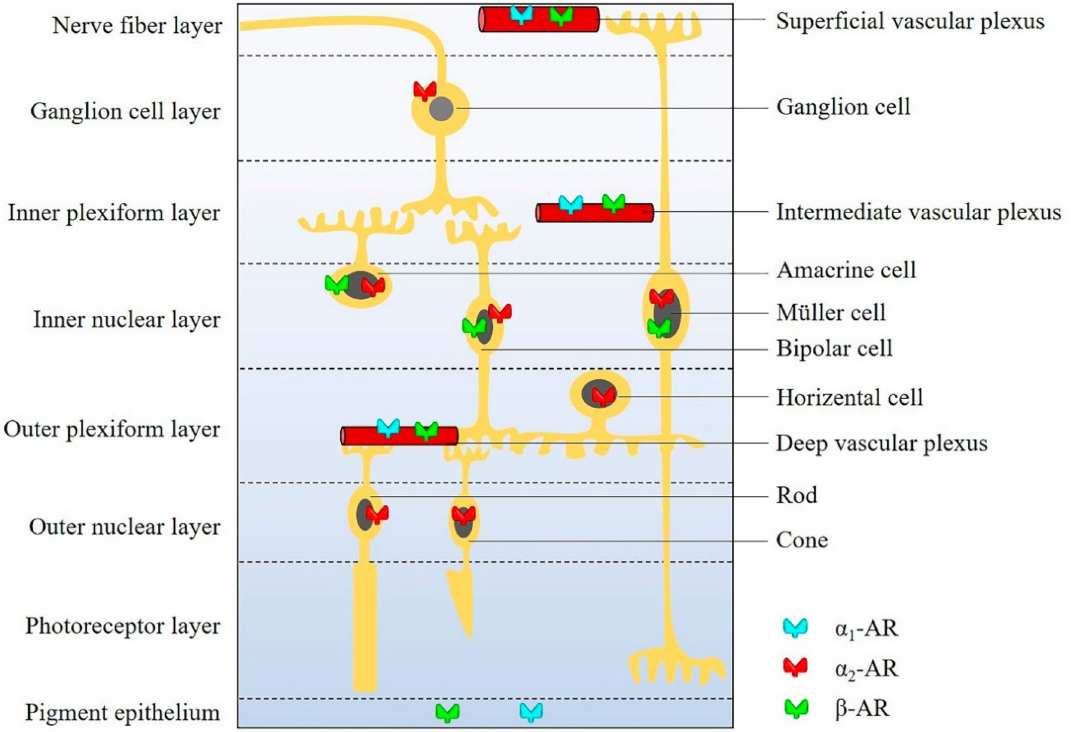
Figure 2. The distribution of ARs in individual retinal layers and